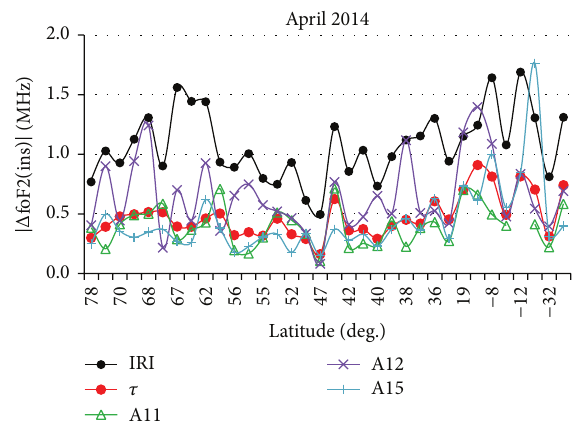
Figure 6: Deviations of foF2 calculated from experimental values around the period of